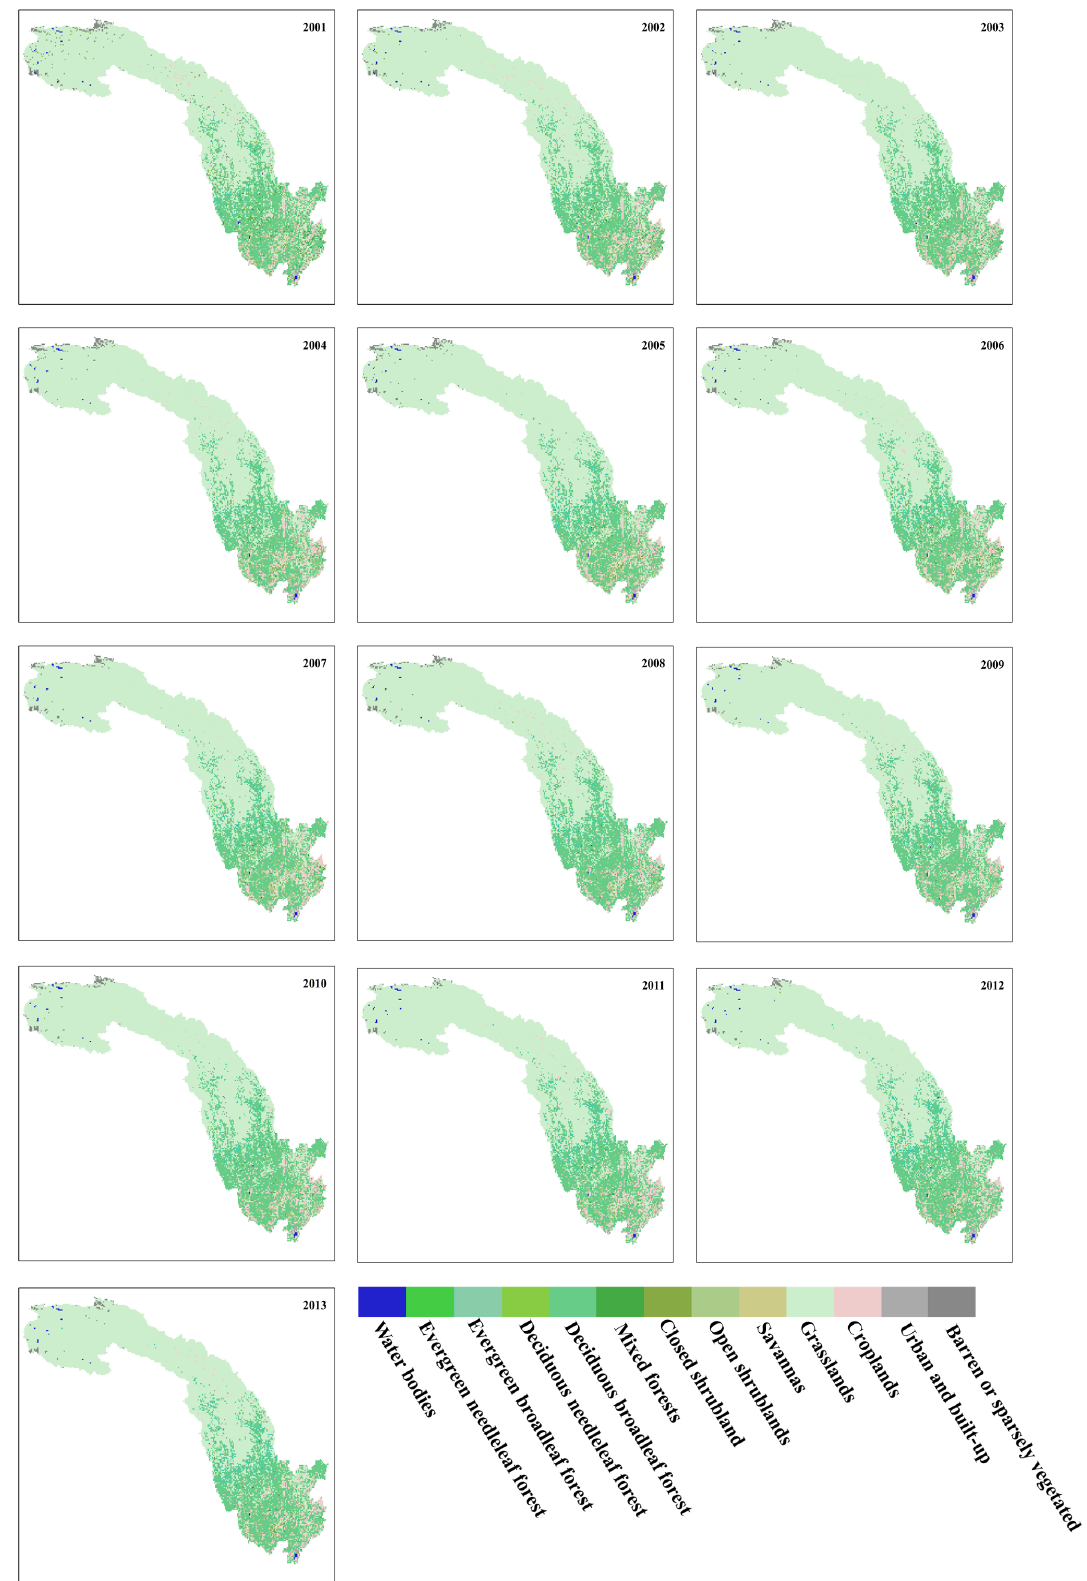
Figure B1. Land cover types over the Jinsha River basin from 2001 to